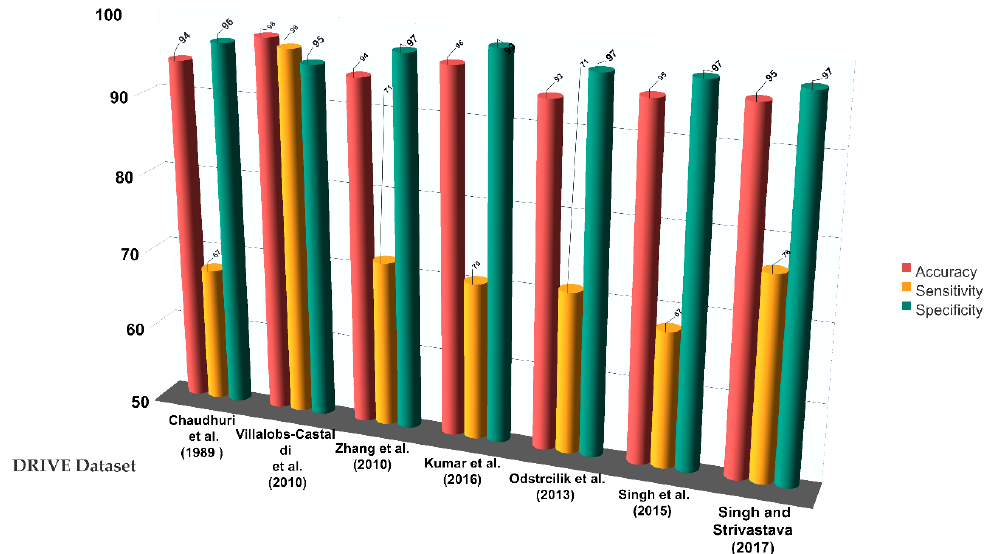
Figure 9. Summarized graphical comparison between some of kernel-based methods performance ( Accuracy , Sensitivity and Specificity ) based on DRIVE dataset. ( Accuracy , Sensitivity and Specificity ) based on DRIVE